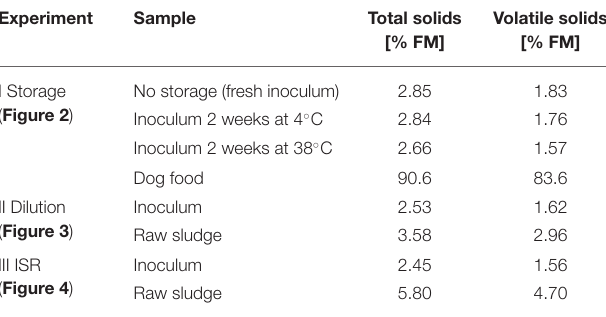
TABLE 1 | Characteristics of inoculum and substrates used in each experiment.